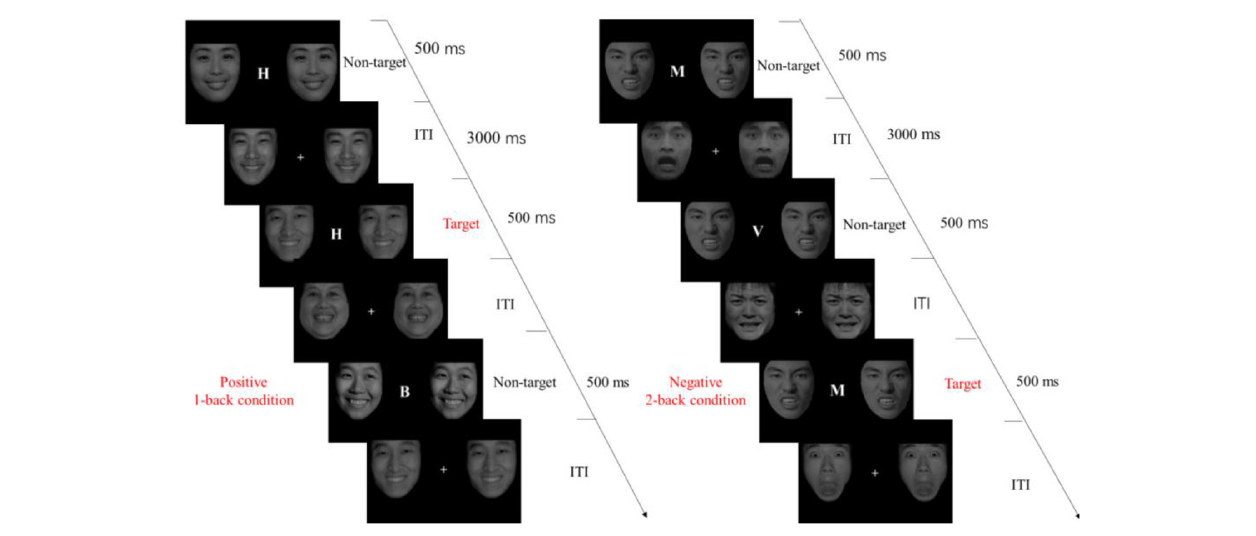
FIGURE 3 | Emotional N -back task design. When the experiment began, a white fixation cross was displayed in the center of the screen for 500 ms, and then a random letter was displayed in the center of the screen with same EF pictures on both sides for 500 ms. After 3,000 ms another picture with a letter in the center and EF pictures on both sides were displayed for 500 ms, and participants were asked to judge whether this letter was the same with the letter they saw one screen back (1-back) or two screens back (2-back).